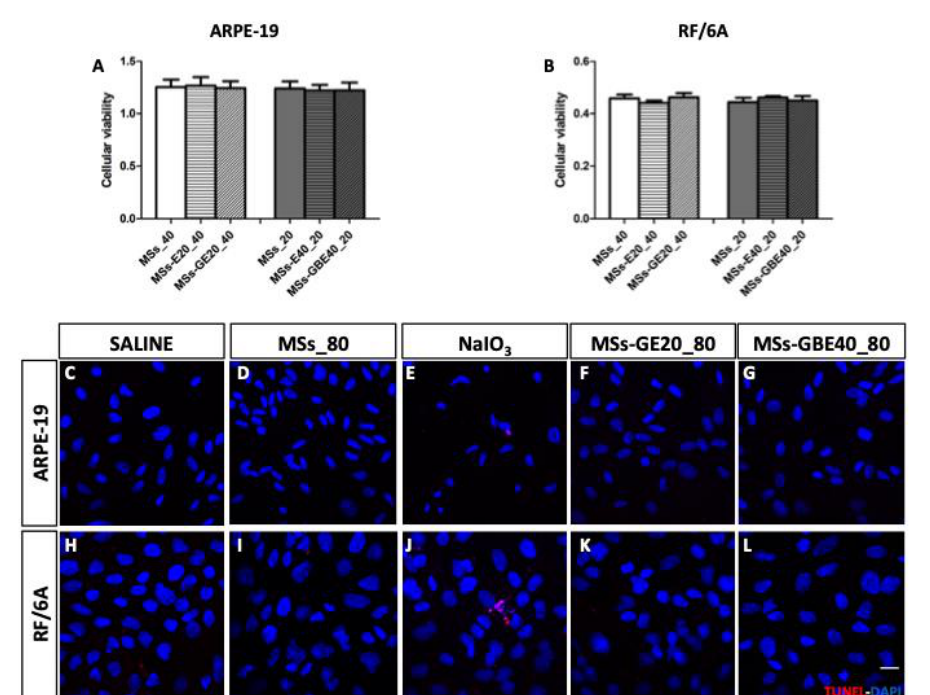
Figure 3. Safety and apoptosis of the delivery of neurotrophins by microspheres. MSs-GE and MSs-GBE showed no alterations in ARPE-19 ( A ) and RF/6A ( B ) cell viability measured by MTT. Blank PLGA MSs and PLGA/Vit E MSs (MSs-E20 and MSs-E40) controls also showed similar cell viability values in ARPE-19 ( A ) and RF/6A cells ( B ). Apoptosis was detected by Terminal deoxynucleotidyl transferase (TdT) dUTP Nick-End Labeling TUNEL (red) and nuclei were stained with DAPI (blue). TUNEL positive cells were only found in ARPE-19 ( E ) and RF/6A ( J ) cells after NaIO 3 treatment for 24 h (1500 µ g/mL for ARPE-19 cells and 500 µ g/mL for RF/6A). TUNEL signal was absent in ARPE-19 ( C , D , F , G ) and RF/6A ( H , I , K , L ) cells after treatment with MSs_80, MSs-GE20_80 and MSs-GBE40_80. Blank MSs (MSs_80); GDNF/VitE(20)-loaded PLGA MSs (MSs-GE20_80); GDNF/BDNF/VitE(40)-loaded PLGA microspheres (MSs-GBE40_80). Scale bar 20 µ m. n = 4 for MTT assay and n = 3 for TUNEL detection.